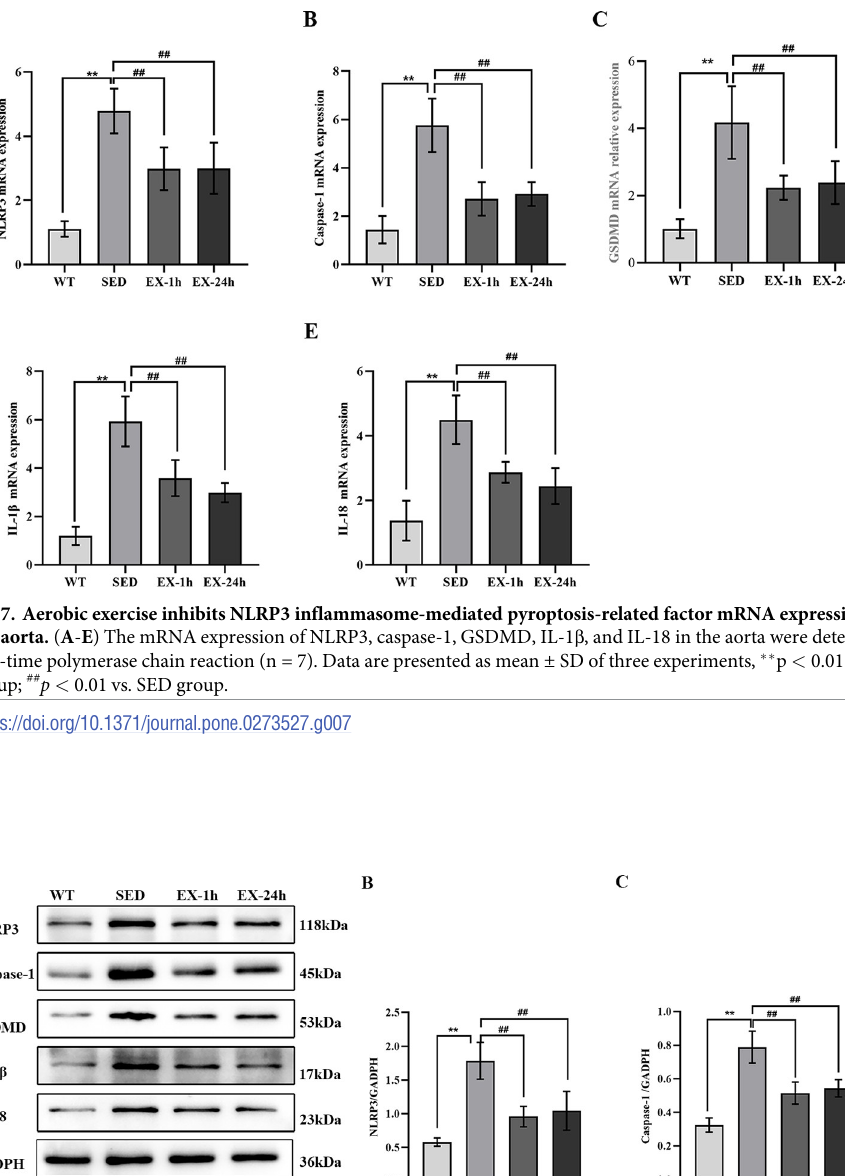
PLOS ONE | https://doi.org/10.1371/journal.pone.0273527 August 25,